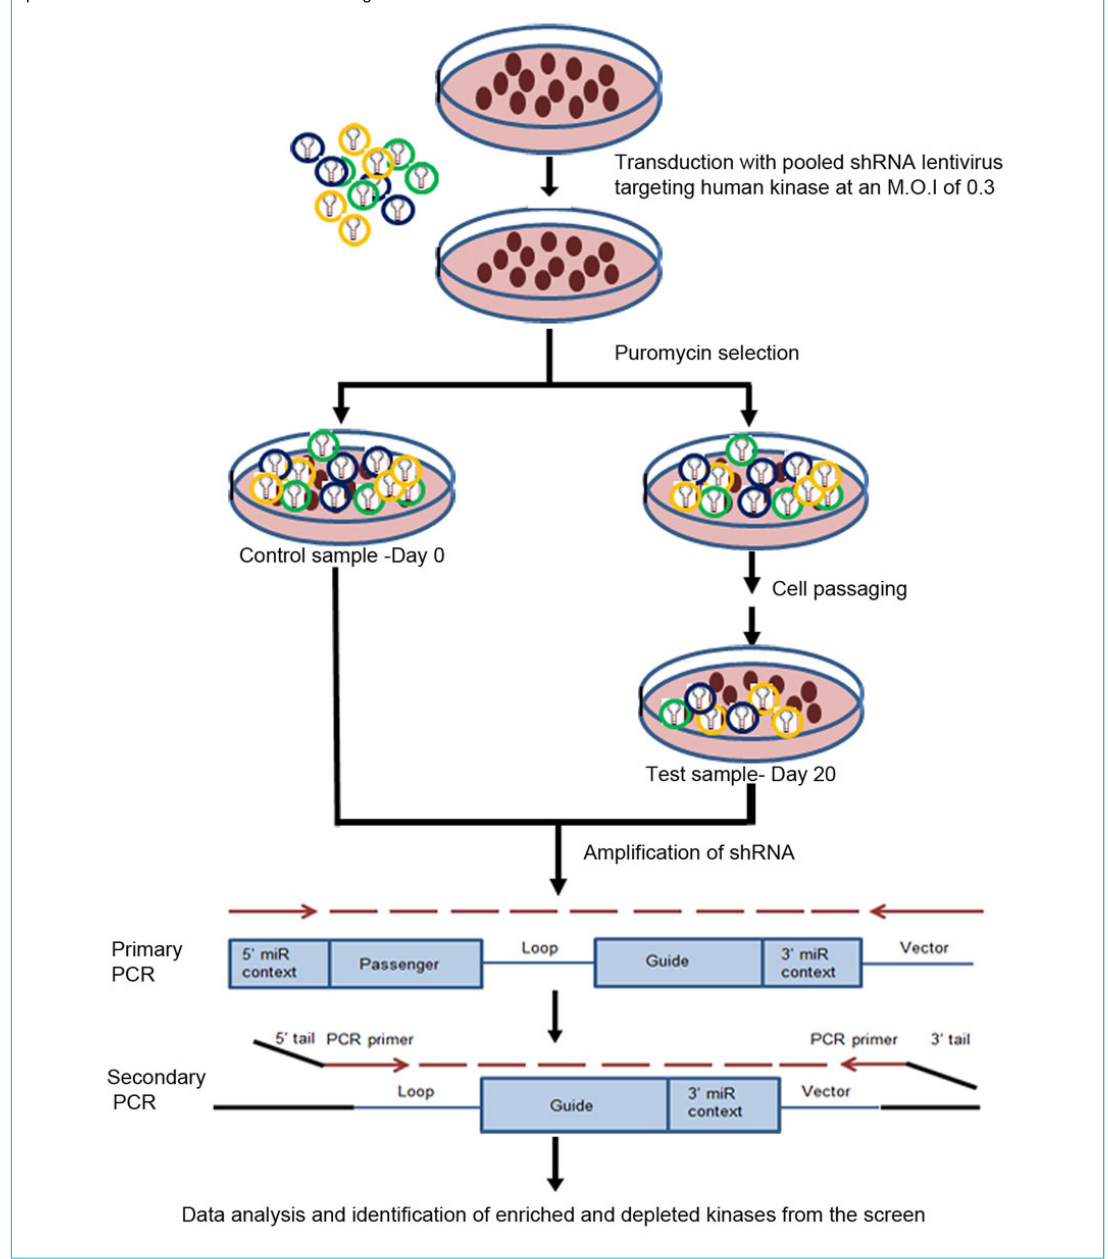
Figure 1: Schematic representation of pooled shRNA screen in AW13516 cells. AW13516 cells were transduced with pooled shRNA lentivirus targeting 906 human kinases at an MOI of 0.3. Cells were selected in puromycin and half the cells were collected as the day 0 sam- ple, which was used as the reference or control sample, as it represents all the shRNA after transduction. The remaining half of the cells were passaged for up to 20 days in culture and collected as the day 20 sample. Genomic DNA was extracted from both samples and shRNA se- quences were amplified by primary and secondary PCR. Then the indexed library, secondary PCR product was sequenced and shRNA counts were obtained for both samples. The shRNA sequences which were depleted in the day 20 compared to the day 0 ones were considered. De- pleted kinases are those which have an oncogenic role in these cells.